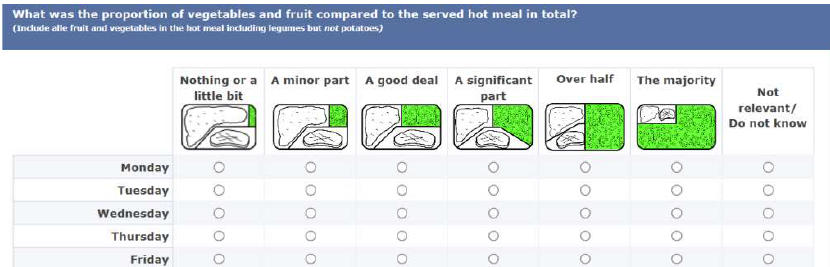
Figure 1. Question on the relative content of fruit and vegetables in the hot meals (Monday to